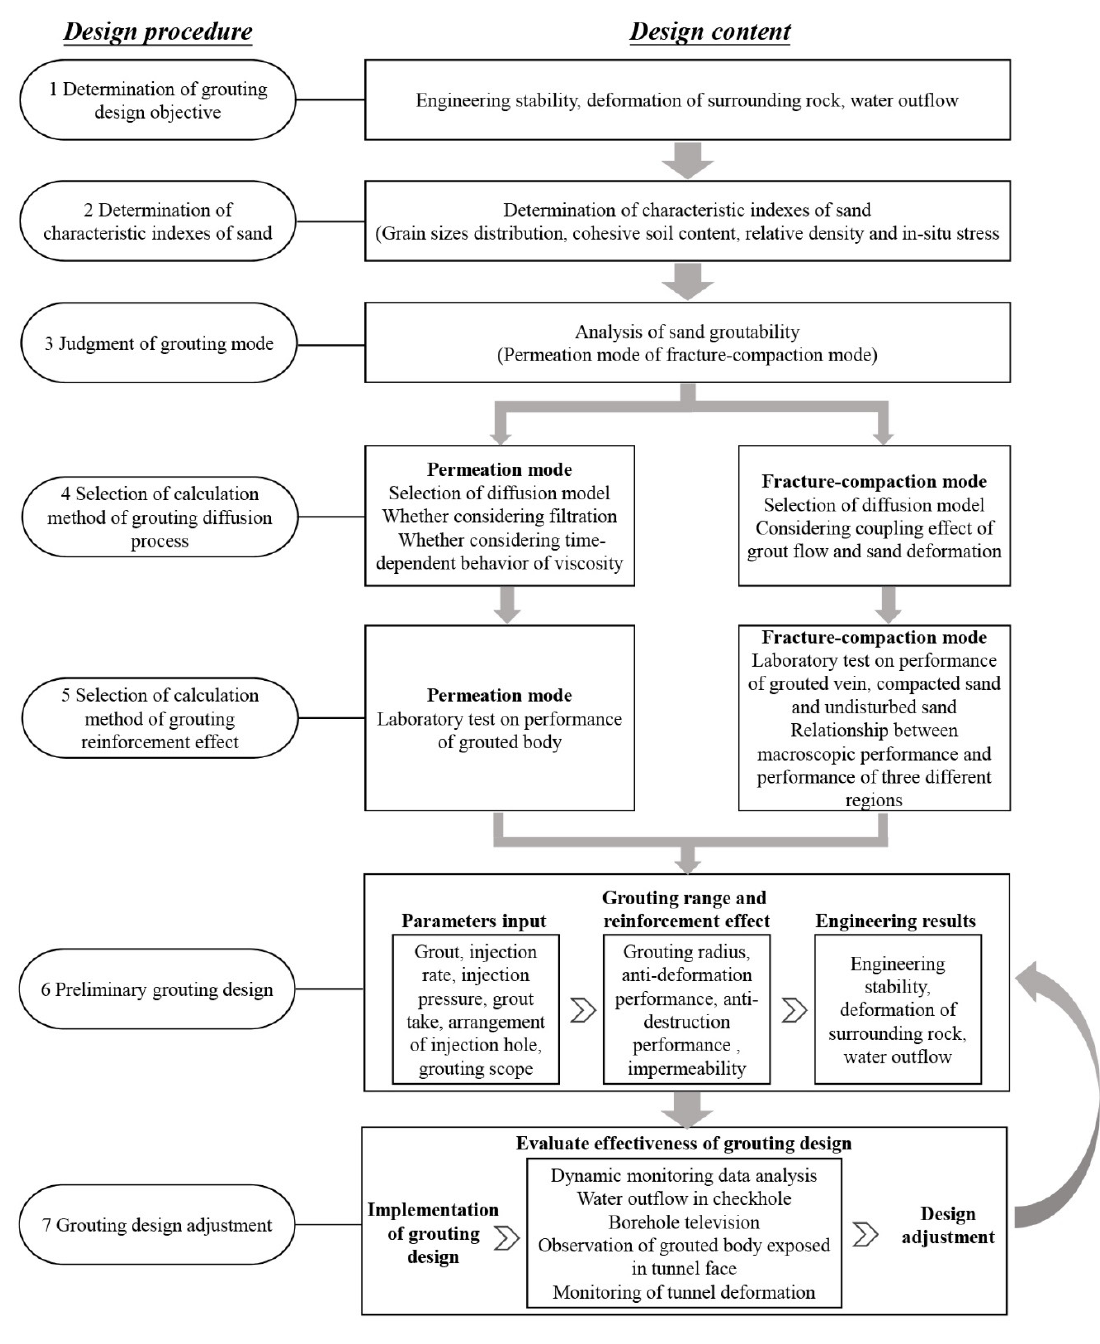
Figure 1. Design procedure for sand